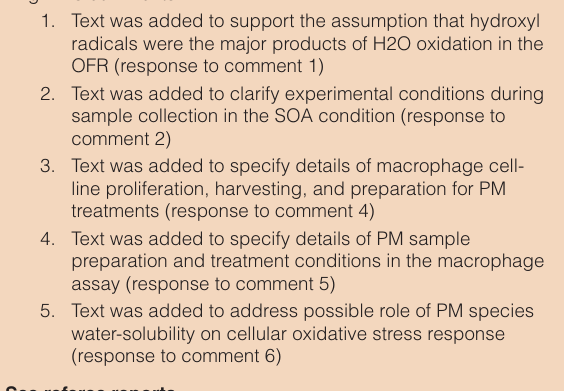
Activated Carbon